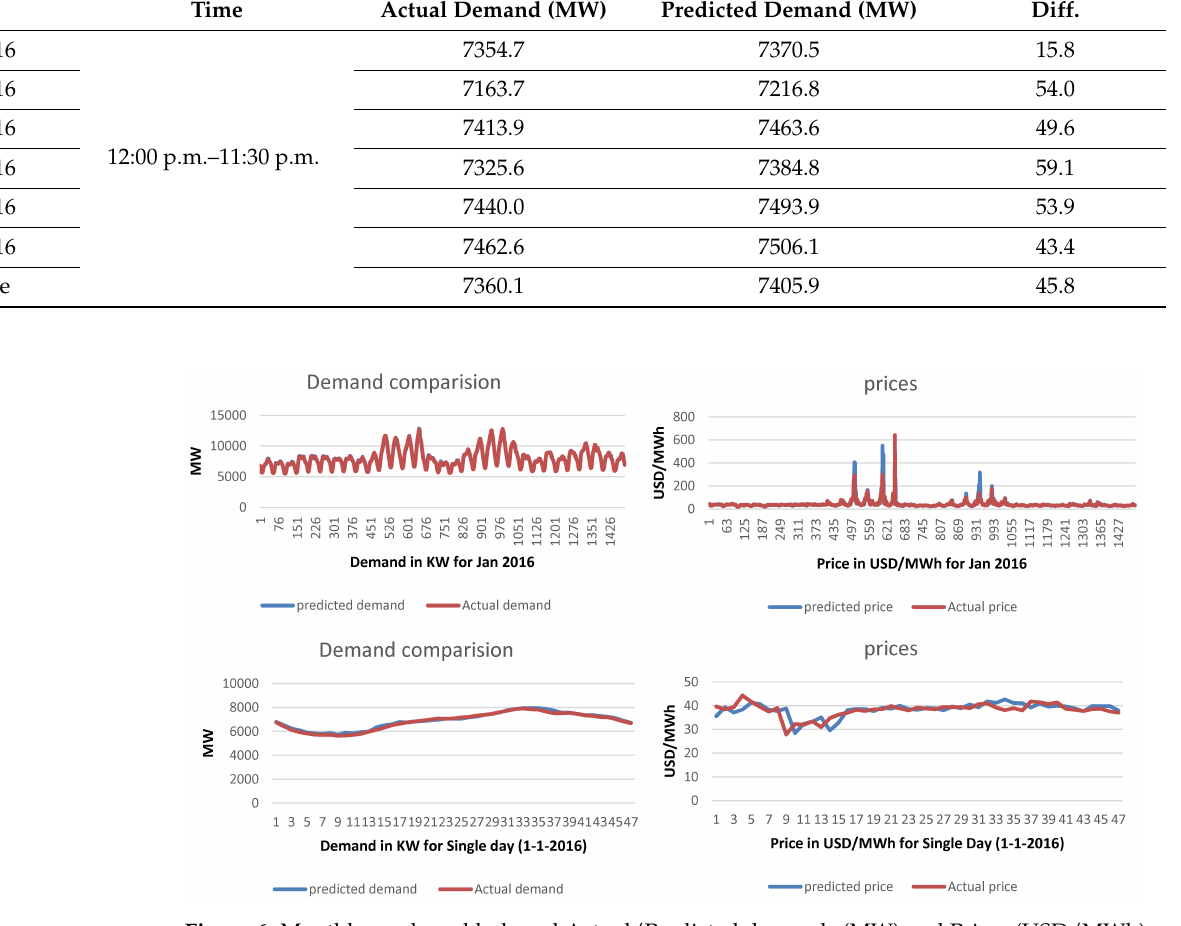
Figure 6. Monthly- and weekly-based Actual/Predicted demands (MW) and Prices (USD/MWh). Analysis of actual and expected demand for 2016–2020 was conducted in